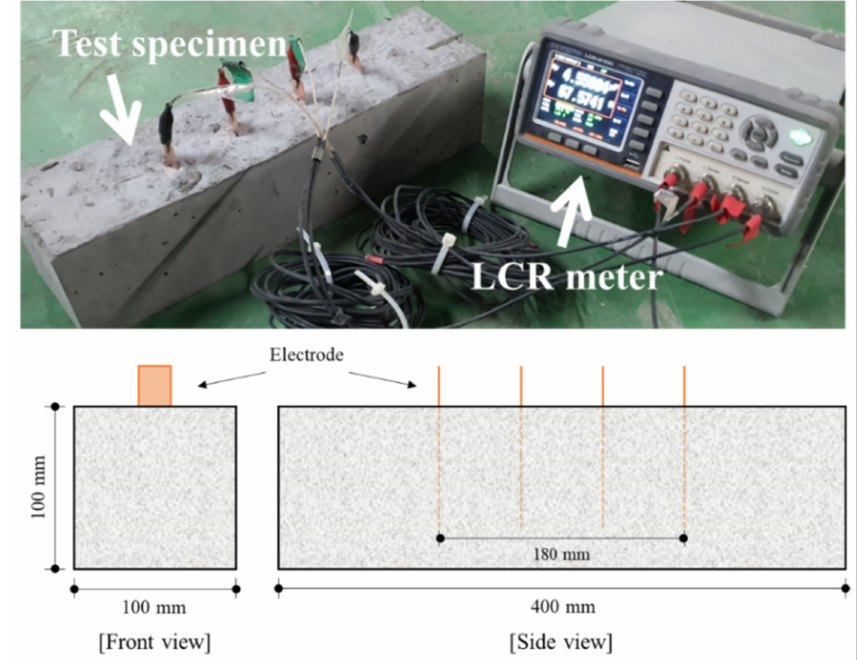
Figure 3. Measurement of electrical resistance of